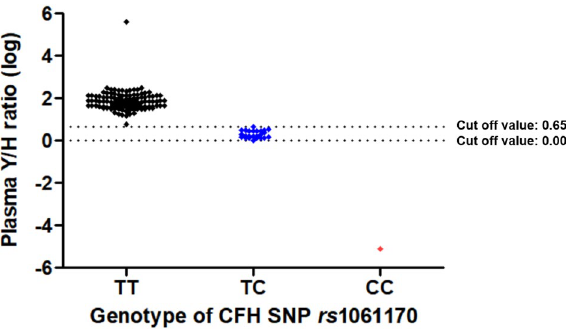
Figure 3. The distribution of logarithm plasma CFH tyrosine/histidine variant protein ratio according to the genotype of complement factor H single nucleotide polymorphism rs 1061170. CFH, complement factor H; SNP, single nucleotide polymorphism; Y, tyrosine; H, histidine; log, logarithm.